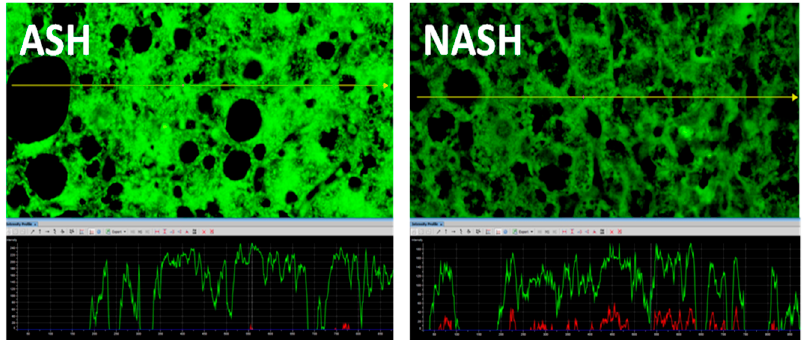
Figure 1. The expression of autophagy ‐ related protein 6 (ATG6) in alcoholic steatohepatitis (ASH) was significantly upregulated compared with non ‐ alcoholic steatohepatitis (NASH) and controls ( p < 0.05). Its expression in NASH was slightly decreased in comparison to controls. Previously published in [21].